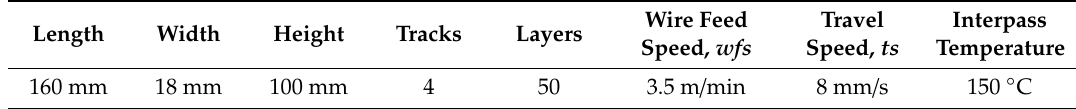
Table 5. Parameters for building the reference wall.